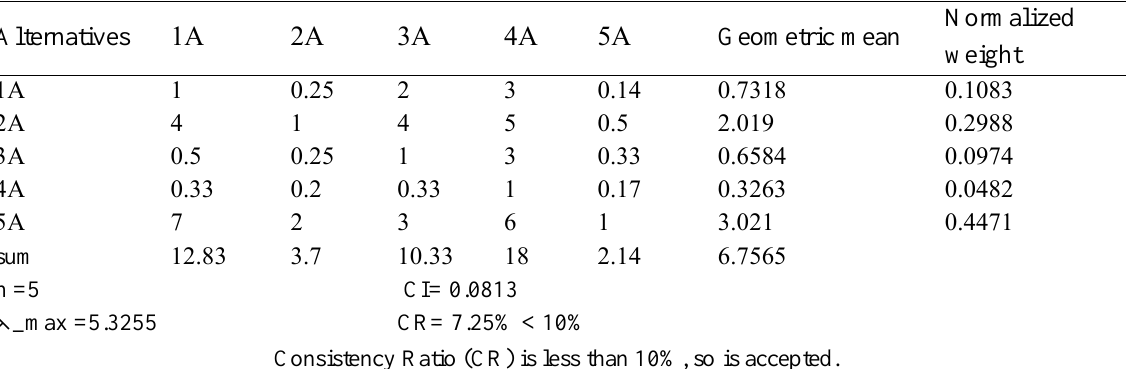
Table 5. Comparison Matrix of Alternatives with respect to C1.